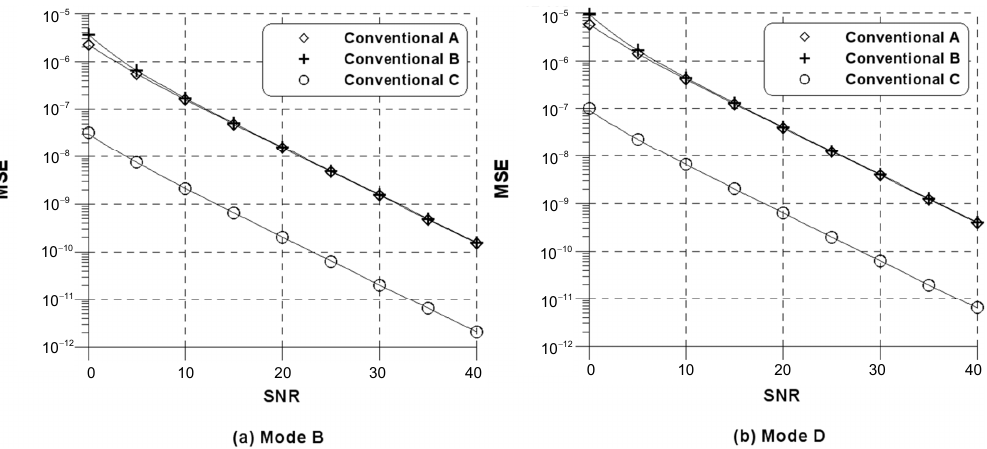
Figure 1. Mean square error (MSE) of the conventional frequency estimators in channel model (CM)1: (1) lines-analysis; (2) symbols-simulation.